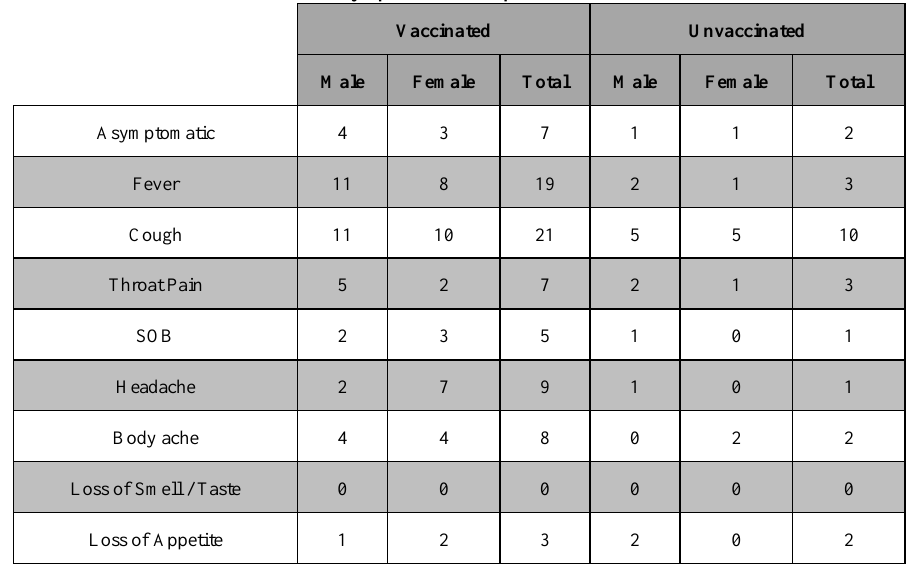
Table 8. Clinical Symptoms with respect to vaccination